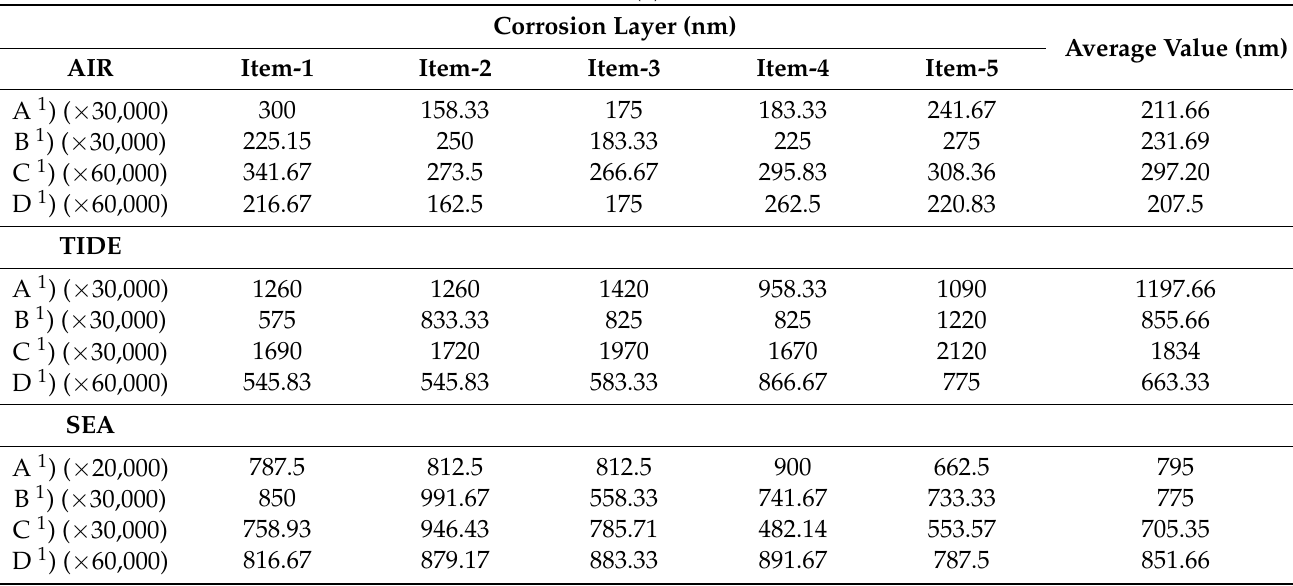
Table 2. Corresponding corrosion wear for air/tide/sea CuAlNi alloy: ( a ) After 6 months, ( b ) after 12